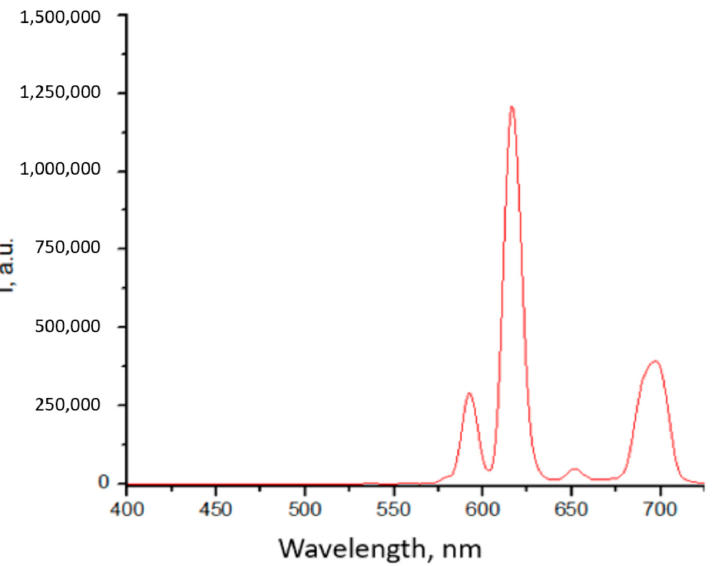
Figure 5. The luminescence spectrum of the Eu(III) complex 10a in DCM at room temperature was obtained by delaying the gate at 305 nm excitation (ligand absorption maximum).